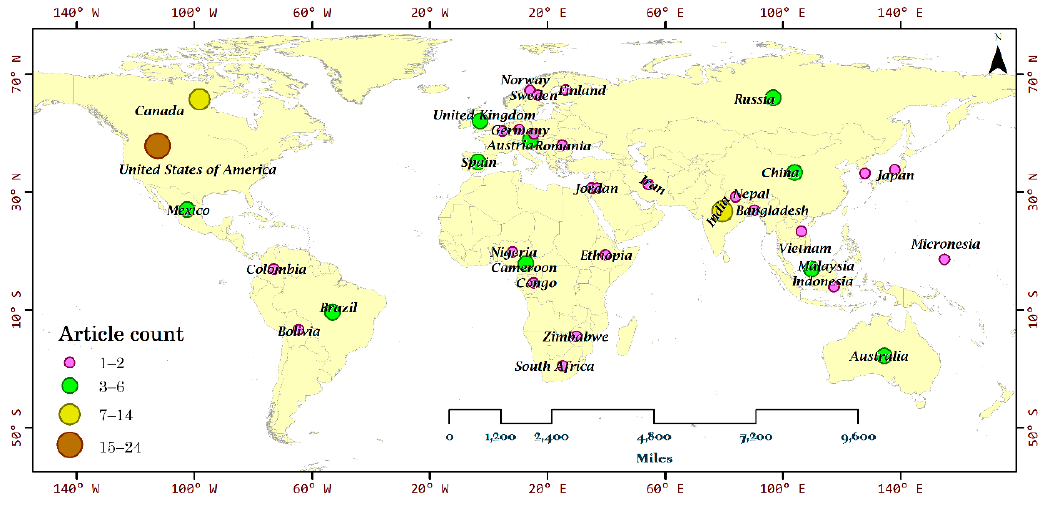
Figure 3. Geographical distribution of forest research.